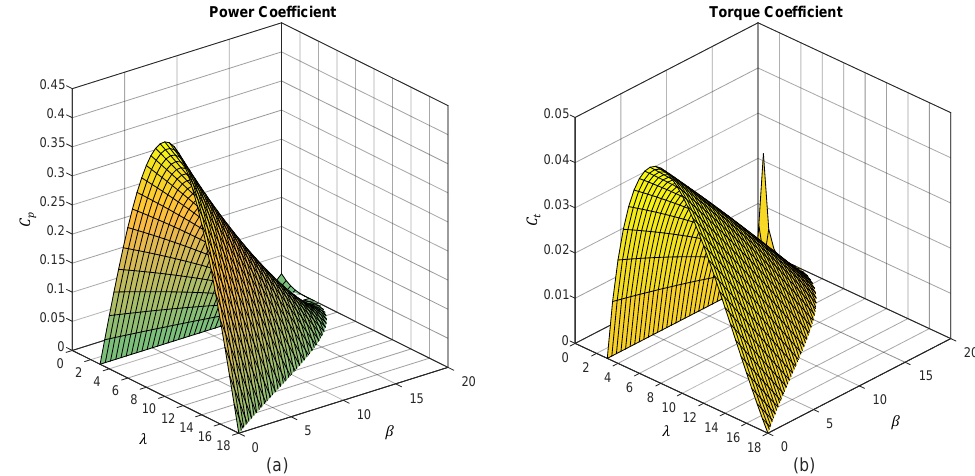
Figure 8. Coefficient proposed by Xin, Wanli, Bin, and Pengcheng [28], with variations of λ and β ; ( a ) power coefficient, ( b ) torque coefficient.